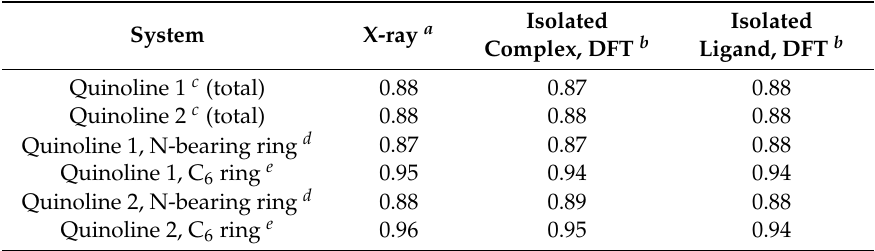
Table 2. HOMED indices for aromaticity in symmetry-independent 4,7-dichloroquinoline ligands. Calibration parameters proposed in [56] have been employed ( α (C=C) = 88.09 Å –2 ; α (C=N) = 91.60 Å –